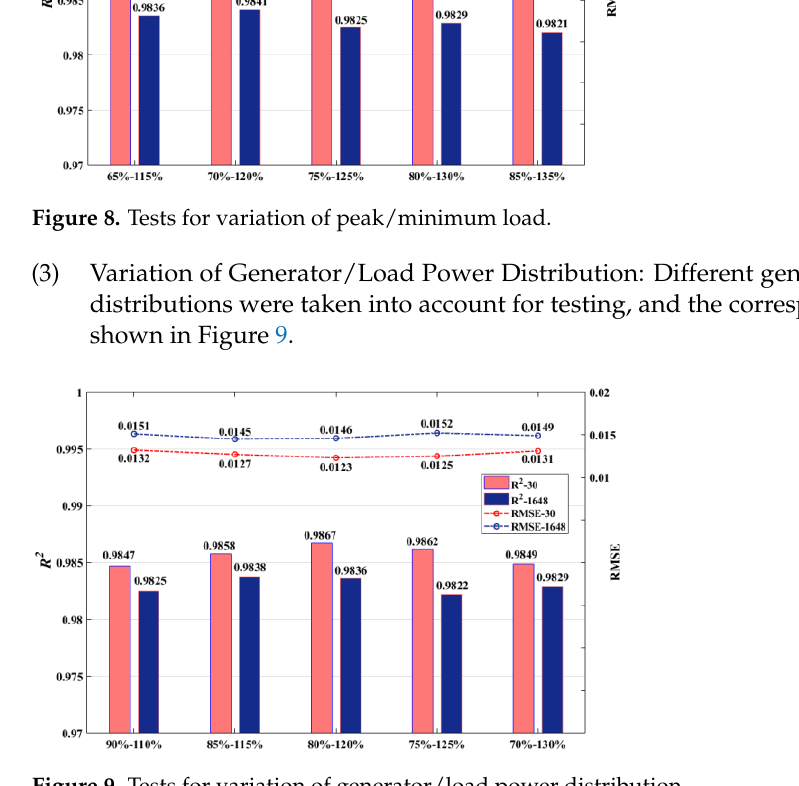
Figure 9. Tests for variation of generator/load power distribution.